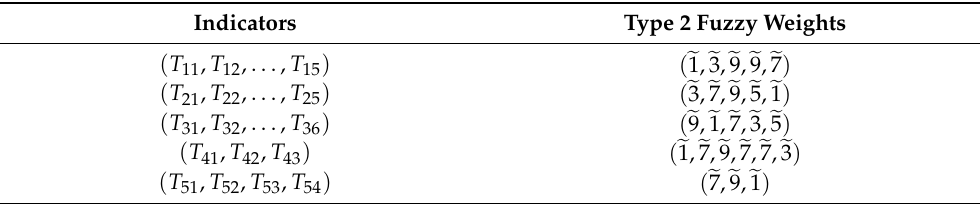
Table 6. Indicator weights given by evaluation experts.